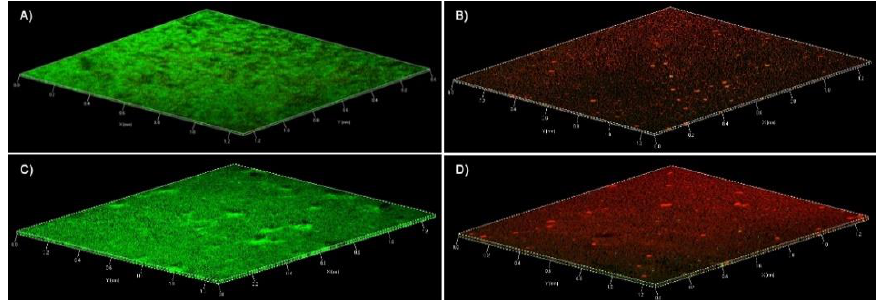
Figure 5. Confocal laser scanner microscopy micrographs of MSSP and MRSP1 biofilms. The panels contain three-dimensional images, green and red fluorescence is associated with live and dead cells, respectively. ( A ) MSSP untreated biofilm ( B ) MSSP biofilm treated with abietic acid at 20 µg/mL ( C ) MRSP1 untreated biofilm ( D ) MRSP1 biofilm treated with abietic acid at 40 µg/mL.